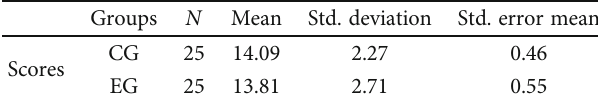
Table 1: Group statistics (pretest of both